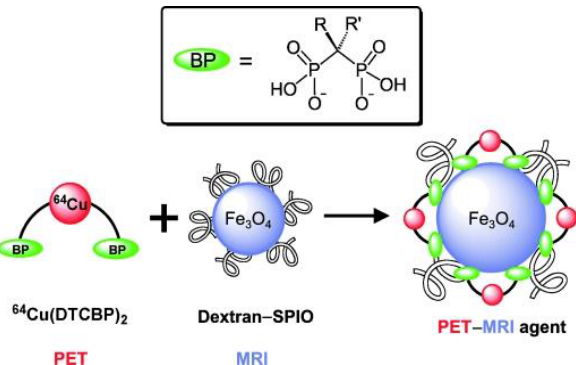
Figure 29. Conjugation reaction between the BP-based PET tracer [ 64 Cu(dtcbp) 2 ] and the dextran- coated iron oxide nanoparticle MRI probe Endorem/Feridex. Reproduced with permission from [38]. Copyright 2011 John Wiley and Sons.